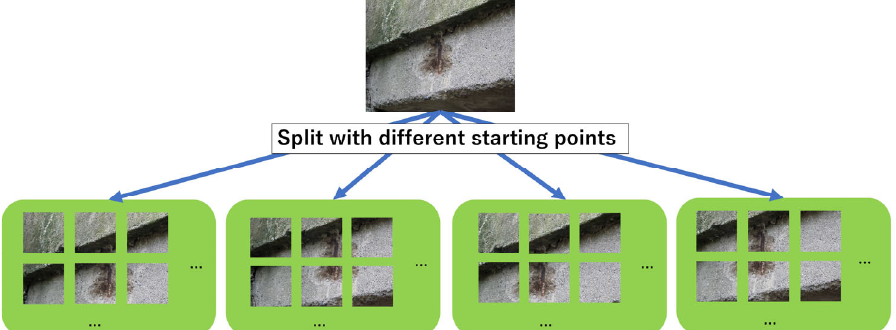
Figure 8. Example of the split images of four different starting points.